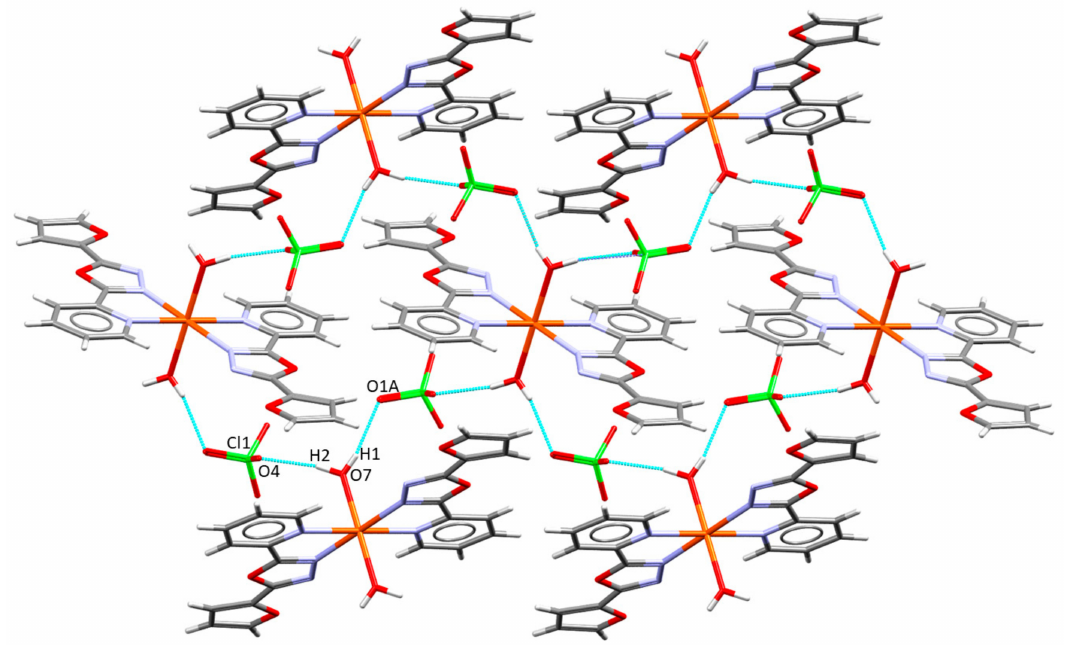
Figure 2. The supramolecular 2D network formed through hydrogen bonds among perchlorates and aqua ligands in the crystal structure of 1. Only atoms involved in the hydrogen bonds are labelled. Table 1. Crystallographic data and structure refinement parameters of the compounds 1 and 2